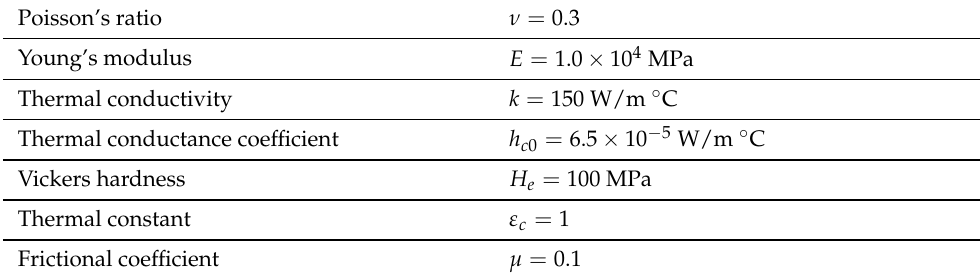
Table 3. Detailed material properties of the frictional sliding problem.